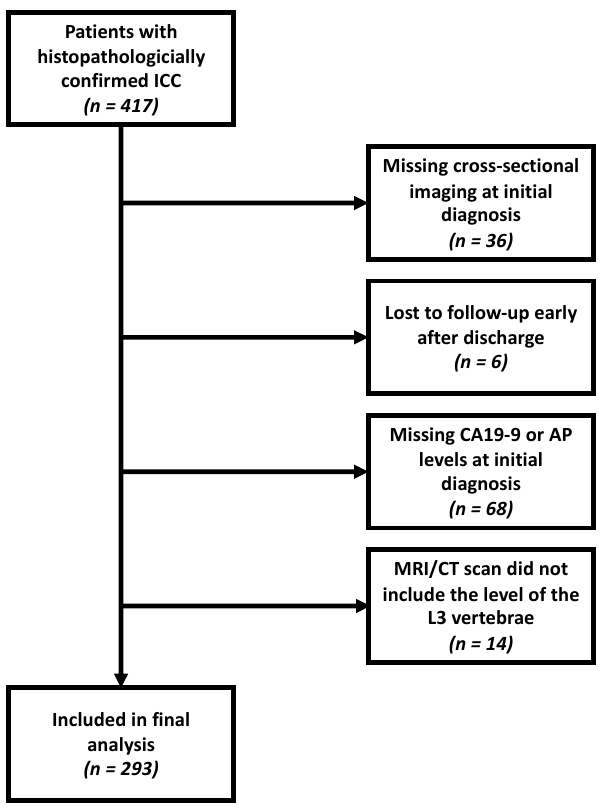
Figure 1. Flow diagram showing the reasons for exclusion from the study. CA19 ‐ 9, carbohydrate antigen 19 ‐ 9. AP, alkaline phosphatase. MRI, magnetic resonance imaging. CT, computed tomography.